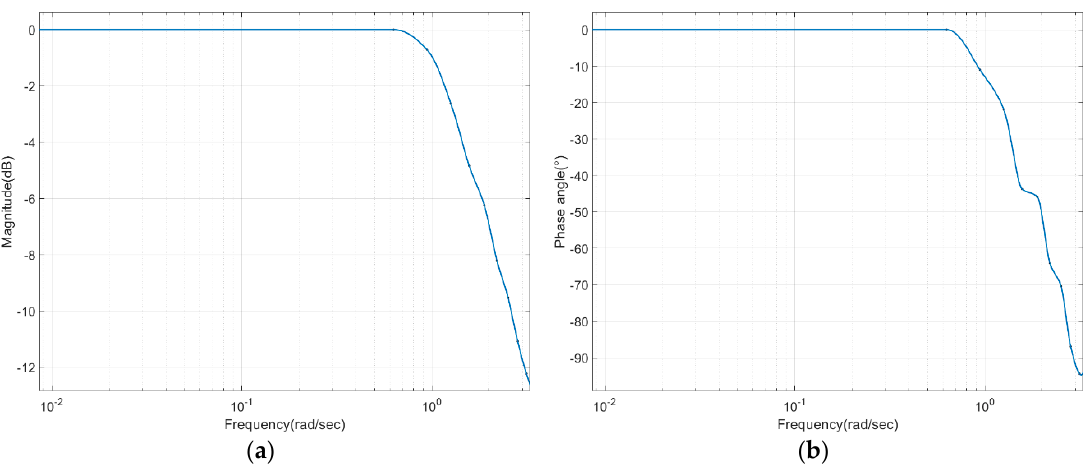
Figure 13. Driving capacity as frequency changes: ( a ) magnitude variation in angle tracking; ( b ) phase variation in angle tracking.